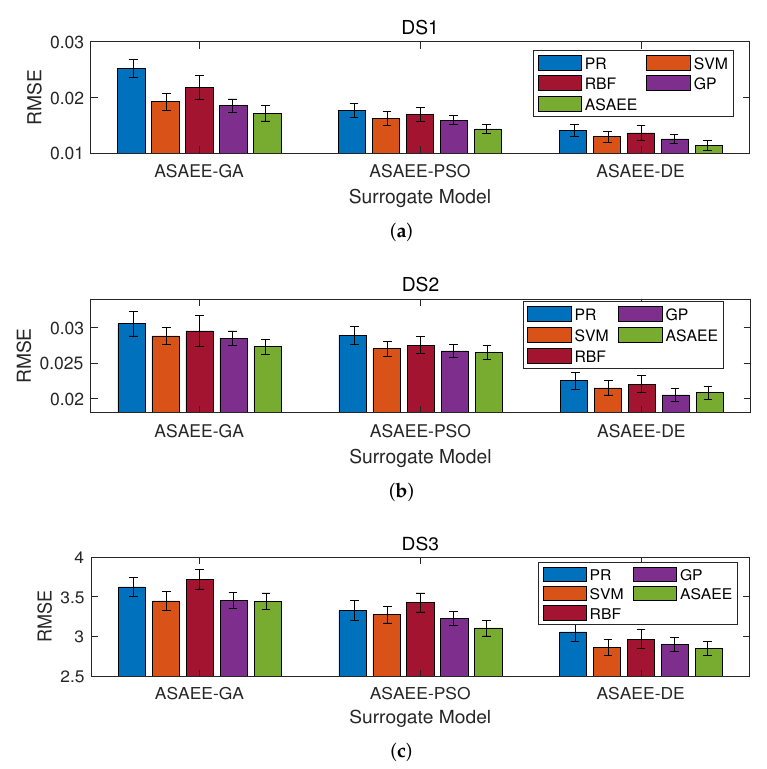
Figure 7. Comparison of the proposed adaptive surrogate-assisted model with other surrogate- assisted models in different data sets. ( a ) DS1. ( b ) DS2. ( c )